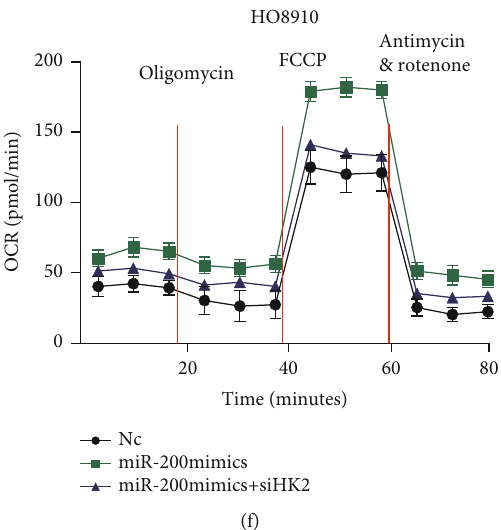
Figure 8: HK2 was regulated by miR-200 and silencing of HK2 abolishes the e ff ects of miR-200 in OC cell lines. (a) Analysis of TargetScan, Pictar, and miRBase datasets identi fi ed 21 genes as potential target of miR-200. (b) Assay of dual-luciferase reporter was performed to explore the binding relationship between miR-200 and HK2 in 293T cells. (c) The expression of HK2 in OC cells with si-miR-200. (d) E ff ect of reintroduction of HK2 on miR-200-mimics cell proliferation by CCK-8 assay; (e) E ff ect of reintroduction of HK2 on miR-200- mimics invasion ability by transwell assay; (f) The oxygen consumption rate was analyzed after transfection of OC cells. ∗∗ P < 0 : 01